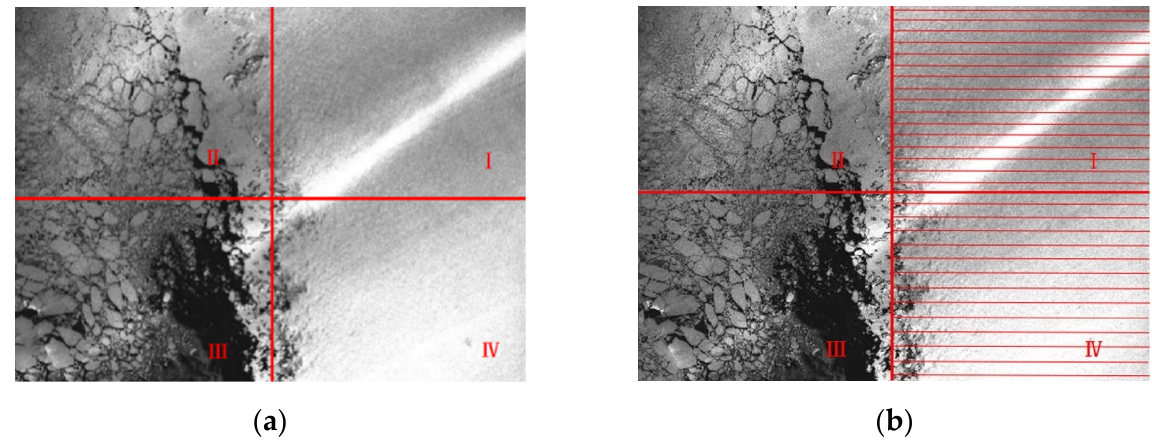
Figure 7. Blocking and selecting. ( a ) Blocking image. ( b ) Selecting blocks Table 1. The coefficients of variation of each